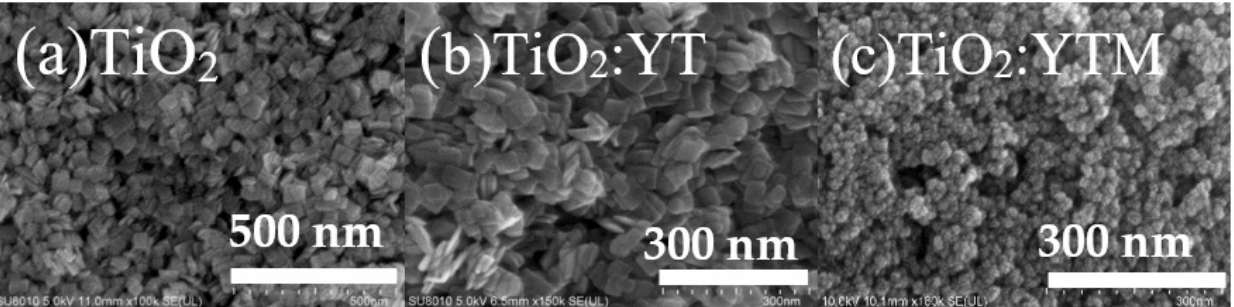
Figure 1. SEM images of ( a ) undoped TiO 2 , ( b ) TiO 2 :Yb 3+ /Tm 3+ [22] (Date from reference [22]) and ( c ) TiO 2 :Yb 3+ /Tm 3+ /Mn 2+ . ( c ) TiO 2 :Yb 3+ /Tm 3+ /Mn 2+